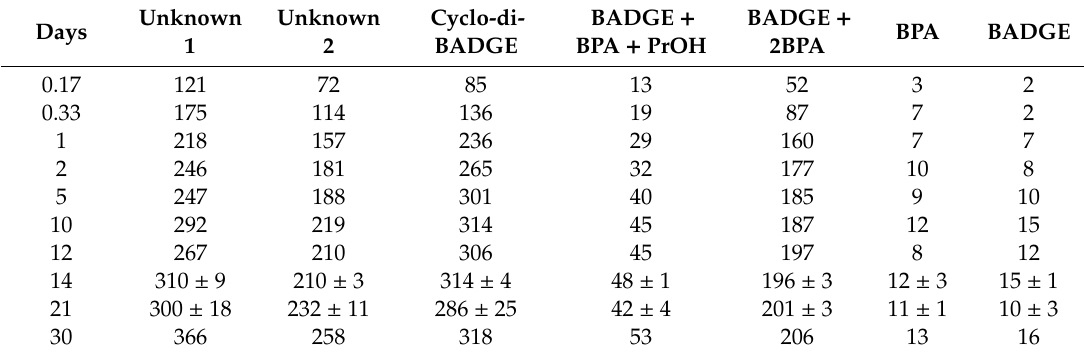
Figure 1. Comparison of migration into 50% ethanol of cyclo-di BADGE at 40 °C ( a ) (data obtained from [34]) and at the accelerated test performed in this study at 60 °C ( b ). Table 1. Concentrations of tracked migrants from epoxy resins into 50% ethanol food simulant during the migration test at 60 ◦ C. Results expressed in µ g / dm 2 . Bisphenol A (BPA), Bisphenol A diglycidyl ether (BADGE), Propanol (PrOH). Unknowns 1 and 2 are listed in Paseiro-Cerrato et al.